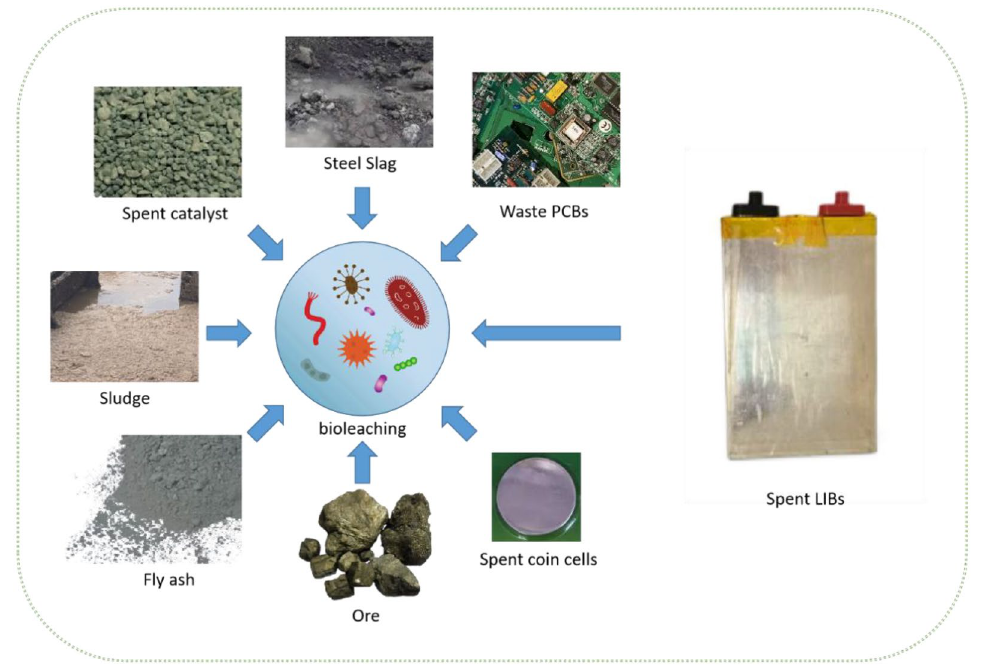
Fig. 2 Examples of bioleaching applications